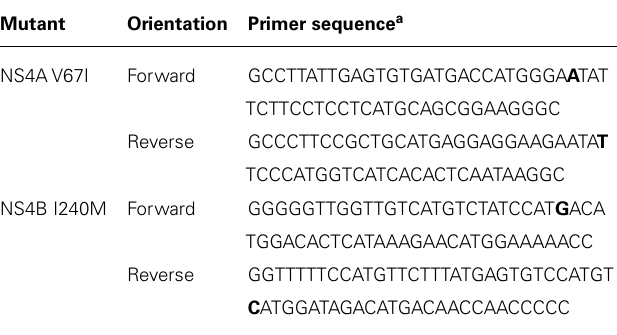
Table 2 | Oligonucleotide primers used for site-directed mutagenesis.